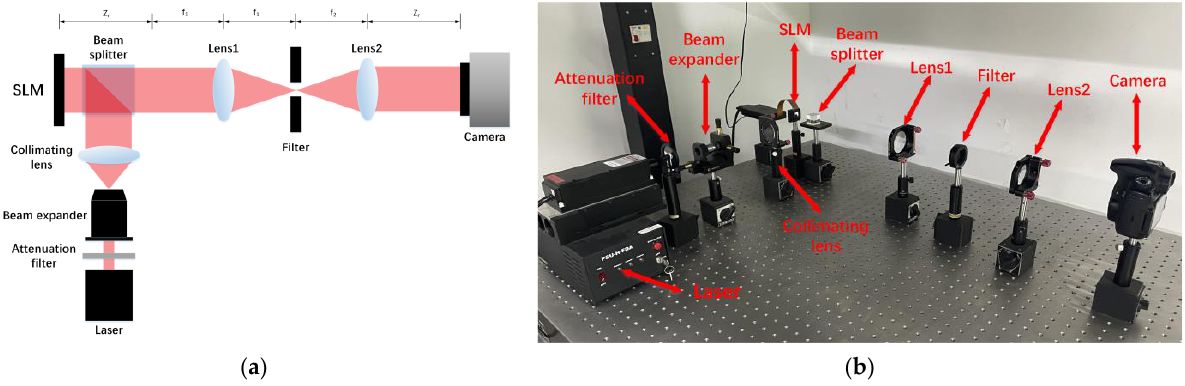
Figure 8. ( a – d ) are the reconstructed results of the SGD method with amplitude loss function and ( e – h ) are the reconstructed results of the proposed method when the distance z r is 230 mm and ∆ z is 10 mm and 30 mm, respectively. ( a 1 – h 1 ) and ( a 2 – h 2 ) are details of ( a – h ) in the red box region, respectively.